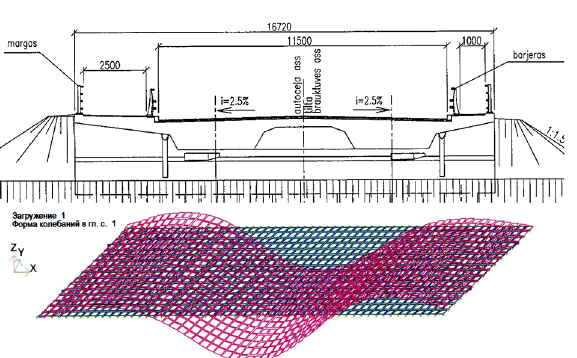
Fig. 11. Cross section and first mode shape of a bridge over Rive Dīvāja on road A6. FE model constructed as a plate-strut 3D system